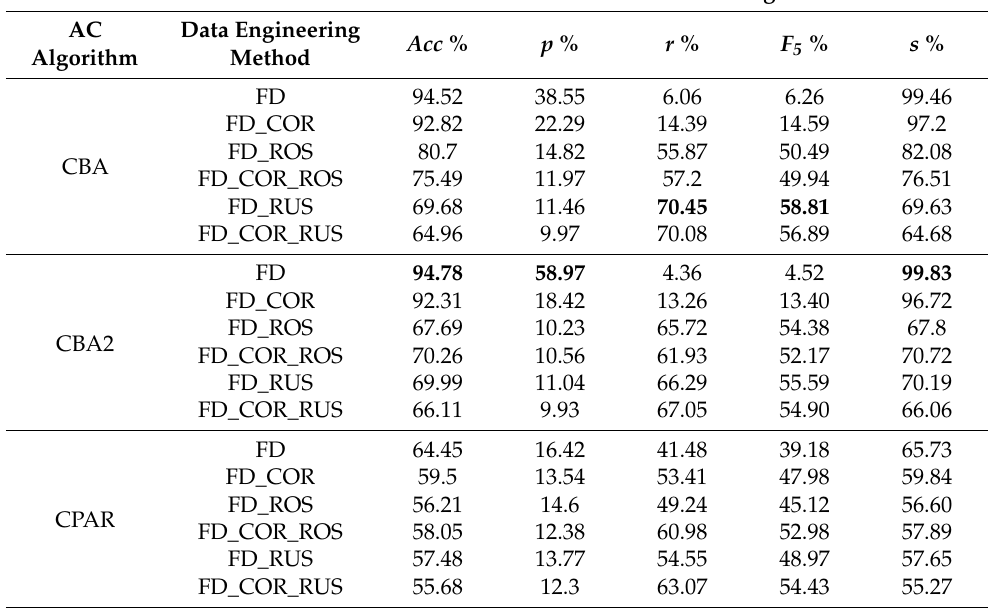
Table 9. Classification assessment of the 18 models produced using the UDW dataset.